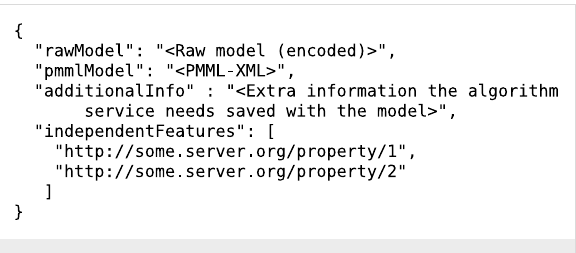
Figure 25: A model returned by JPDI service in JSON format.